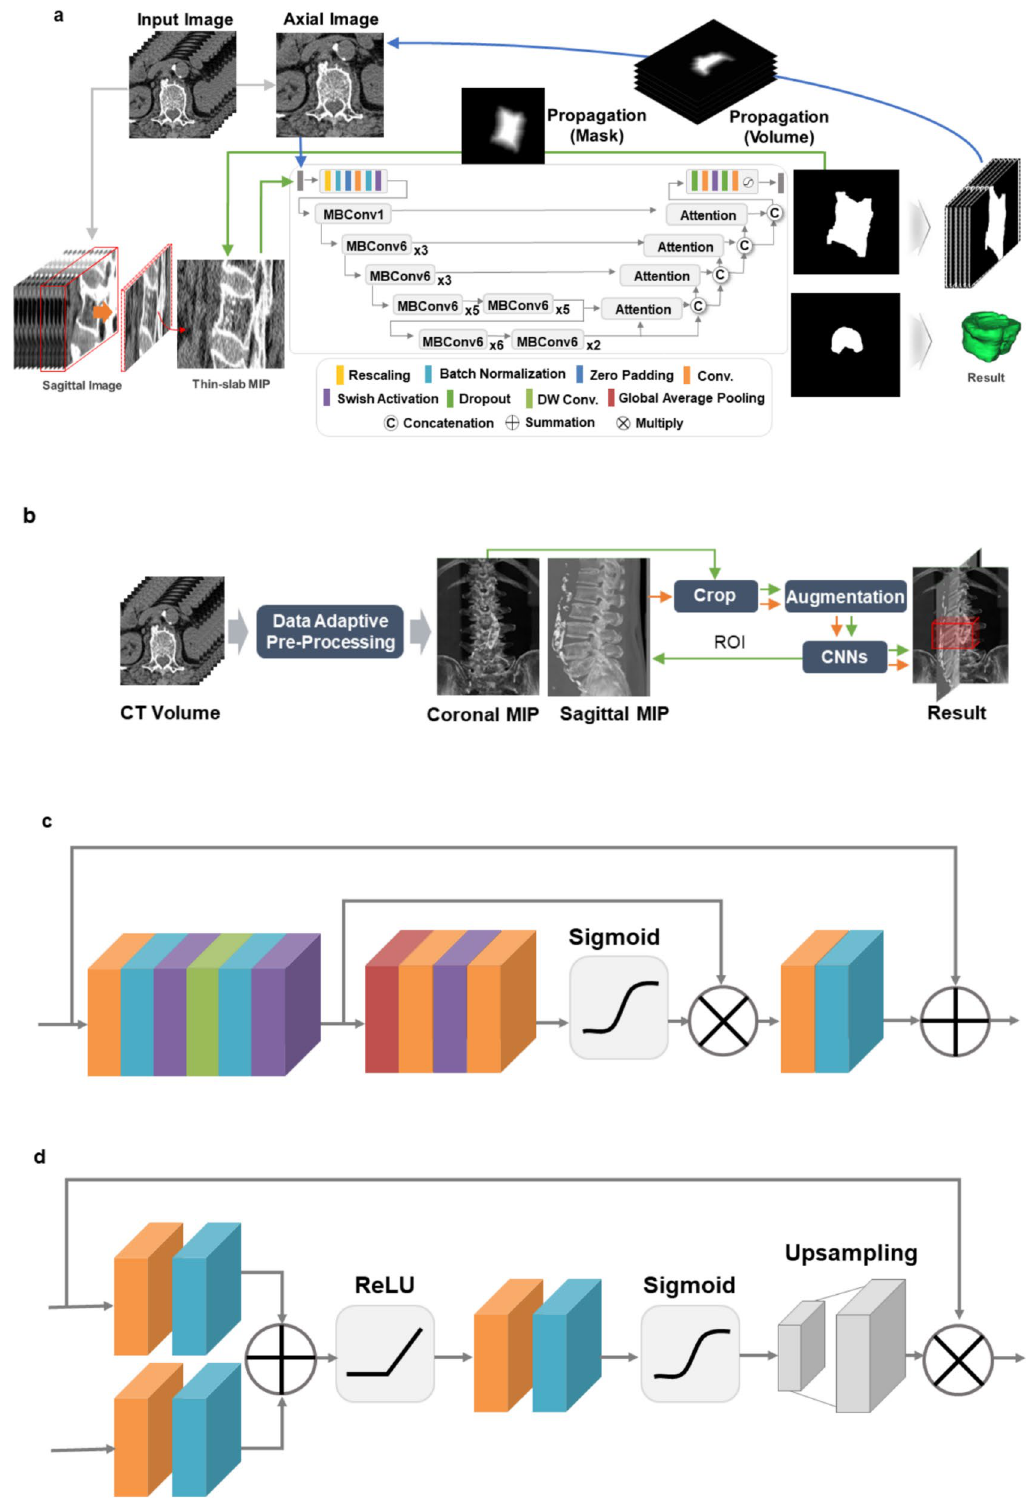
Figure 2. The proposed convolutional neural network (CNN) to segment fractured vertebral bodies on CT. ( a ) Overview of the development of the CNN and its detailed architecture. ( b ) Overall process of vertebral detection. ( c ) MBConV block used for the encoding path. ( d ) Attention block used for the decoding